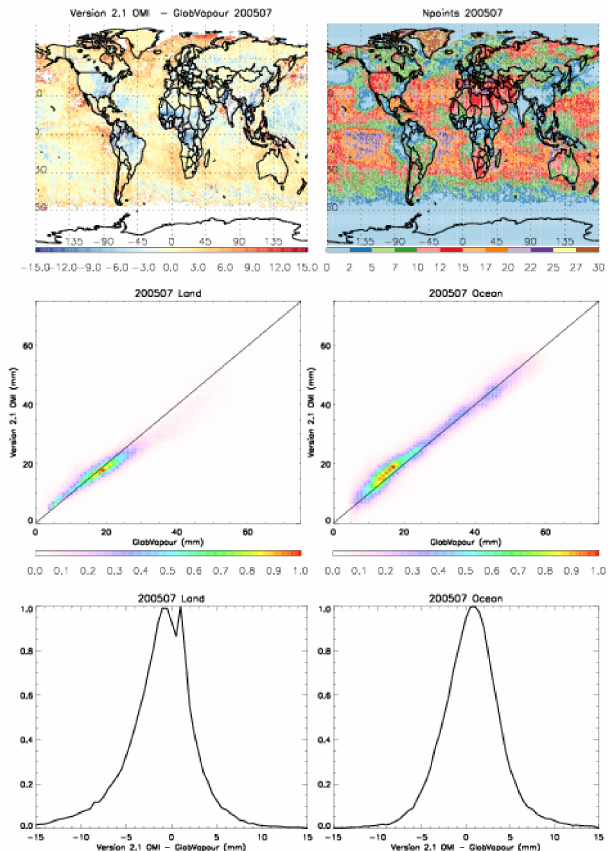
Figure 13. Comparison between version 2.1 OMI (with cloud frac- tion < 5%) and GlobVapour data (1 ◦ × 1 ◦ ) for July 2005. All pan- els are composed using coincident daily gridded data. Top left: monthly mean of OMI − GlobVapour. White areas represent missing data. Top right: number of coincident data points per pixel. Mid- dle row: 2-D normalized histograms of version 2.1 OMI vs. Glob- Vapour for (left) land and (right) ocean. Bottom row: histograms of version 2.1 OMI − GlobVapour for (left) land and (right) ocean.